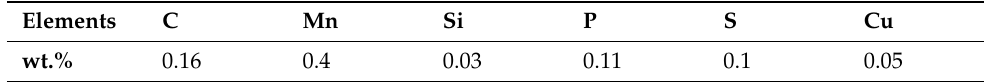
Table 1. Chemical composition of